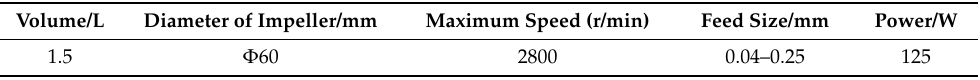
Table 3. Specifications of the single-slot flotation machine.